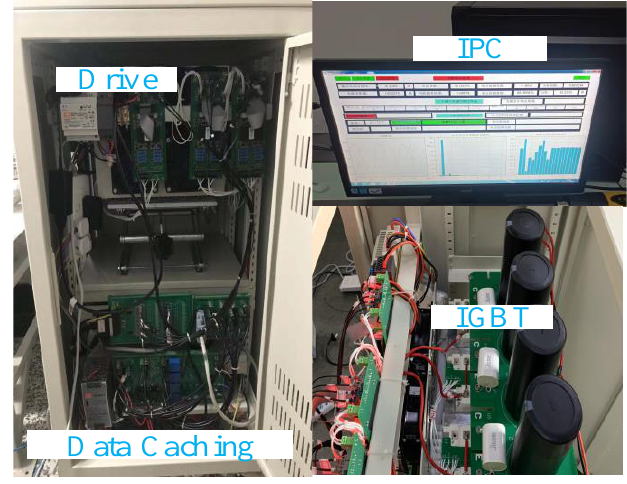
Figure 4. Experimental platform.